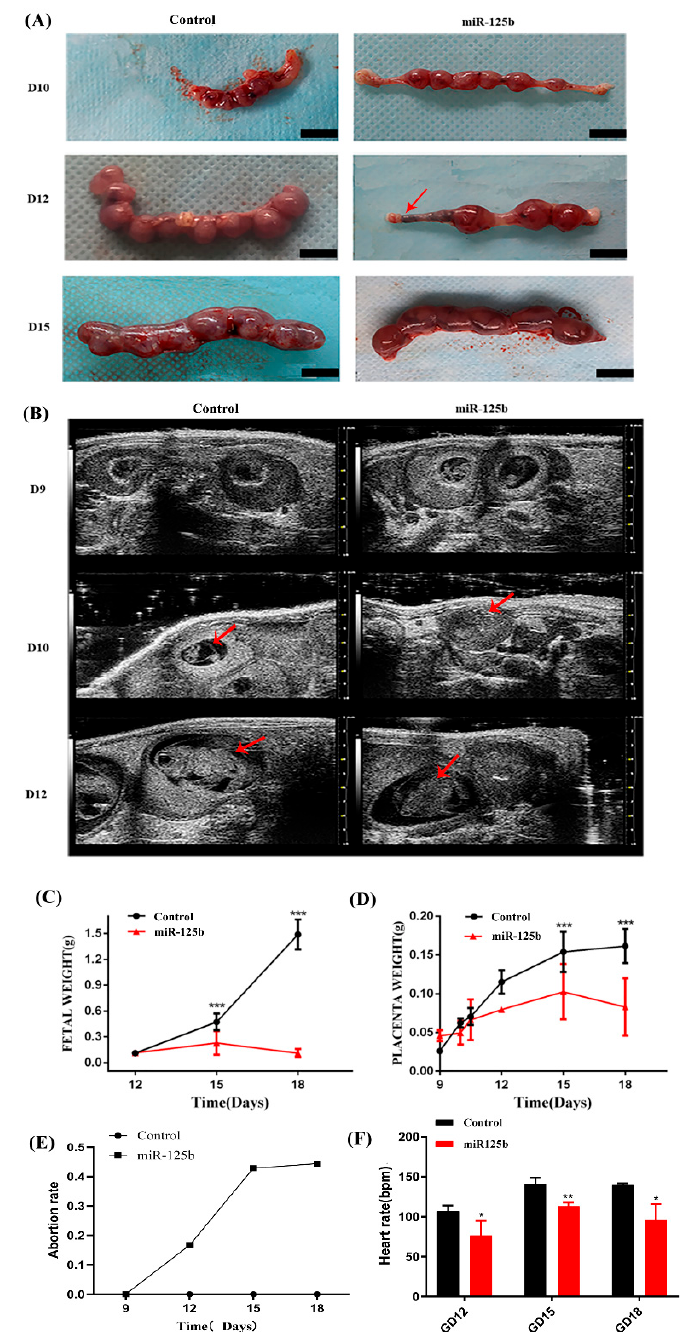
Figure 2. The effect of miR-125b on placenta and fetus in mice ( A ): The placenta and fetus of the GFP group and the miR-125b group on day 10, 12, and 15; ( B ): An ultrasound of mouse on day 9, 10, and 12, the arrows showing embryos; ( C ): the weight of the fetus on different pregnancy days in mice; ( D ): the weight of placenta on the different pregnancy days in mice (*** p < 0.001); ( E ): Abortion rate of miR-125b group; ( F ): The heart rate of the mice model on day 12, 15, and 18. Data are presented as mean ± SEM, n = 10 (* p < 0.05, ** p < 0.01).